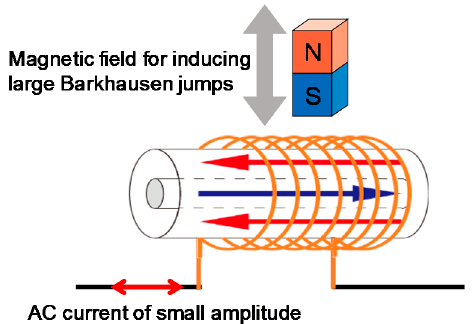
Figure 11. Voltage and current waves when an AC current of 1 mA amplitude is applied. A large Barkhausen jump is caused by the magnetic field of a slow-moving magnet having dimensions of 3 × 3 × 5 mm 3 .